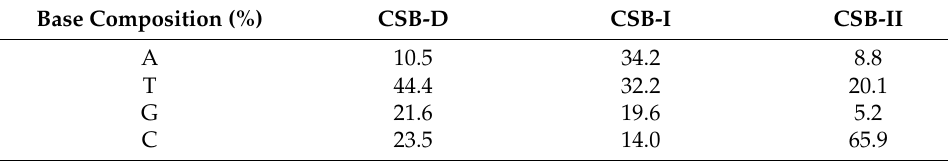
Figure 6. Conserved sequence blocks (CSBs) of the control region in the parrotfish mitogenomes. Table 2. Base composition of the CSBs of parrotfish mitogenomes.